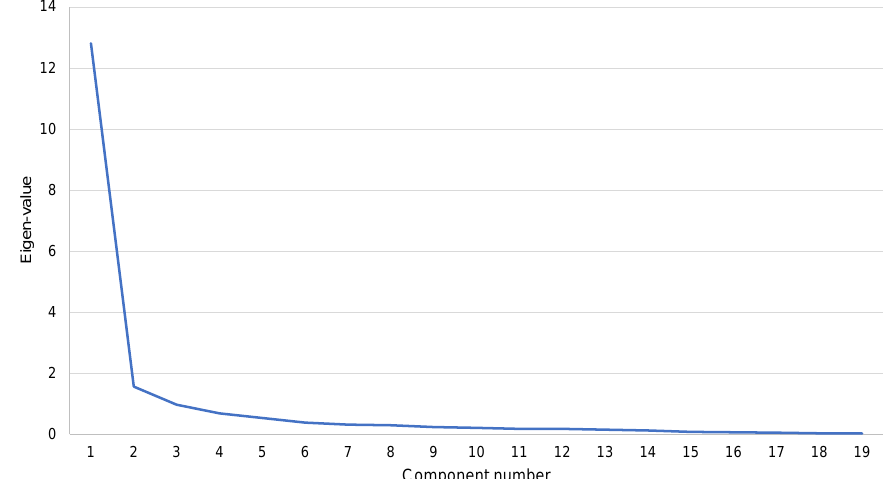
Table 4. Internal consistency results ( n =